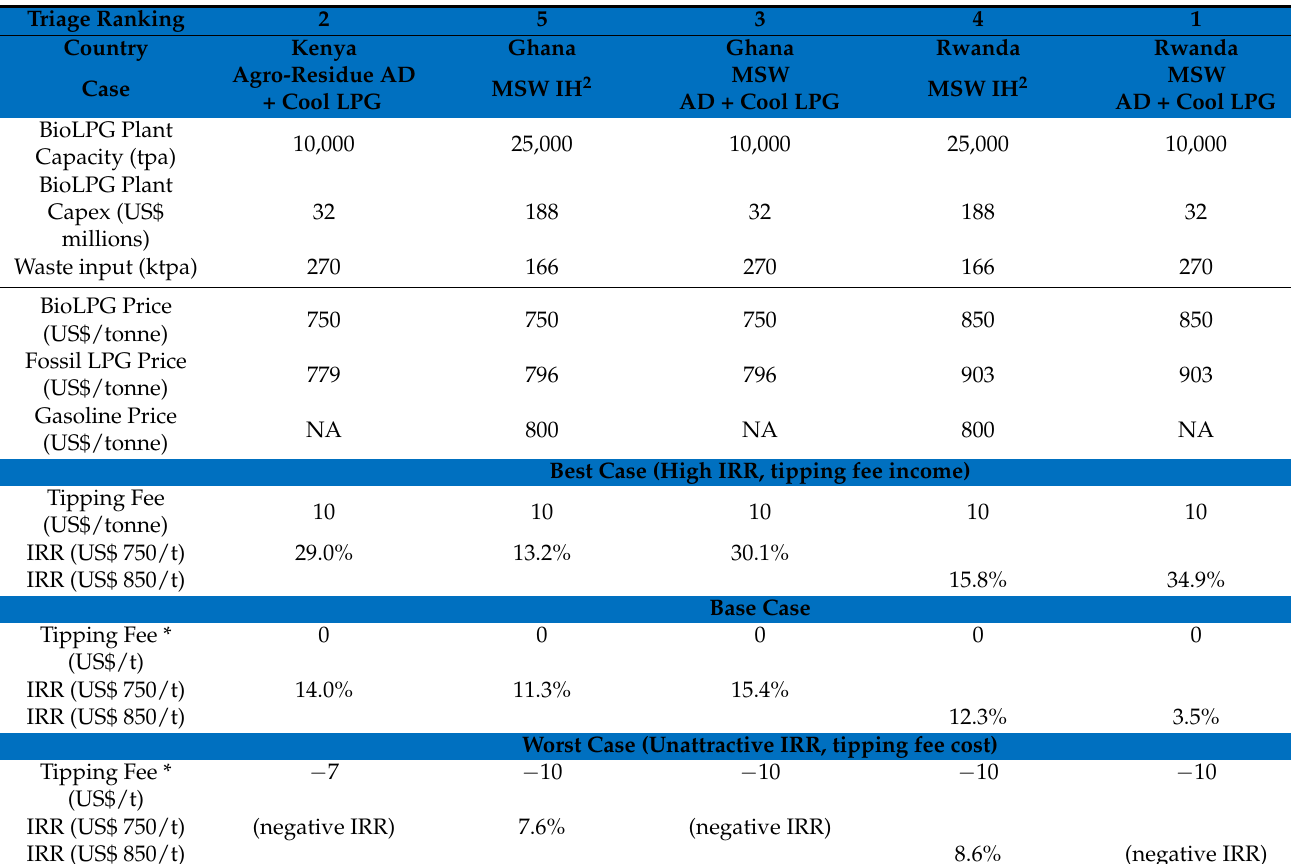
Table 6. Financial characteristics of the five bioLPG pilot